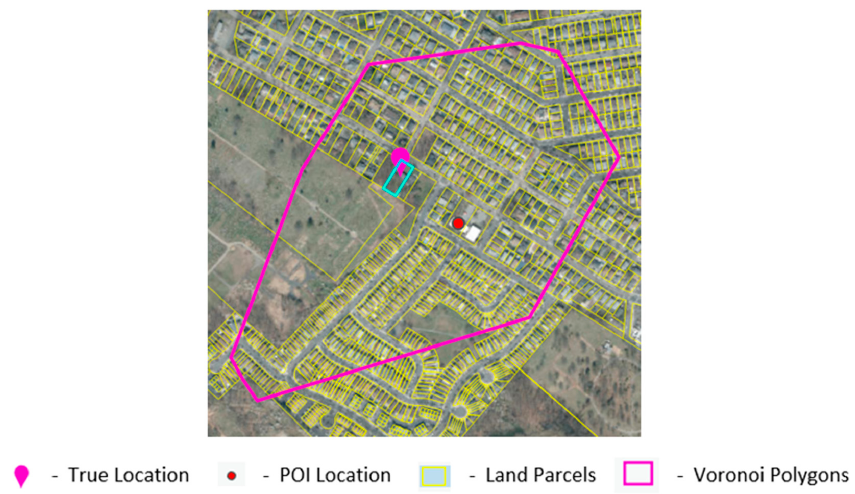
Figure 3. Input parcel p true outlining the true location (highlighted in blue) and the Voronoi polygon v true containing the input true location l t as indicated in steps 1 and 2 of VSBDG (Algorithm 1).